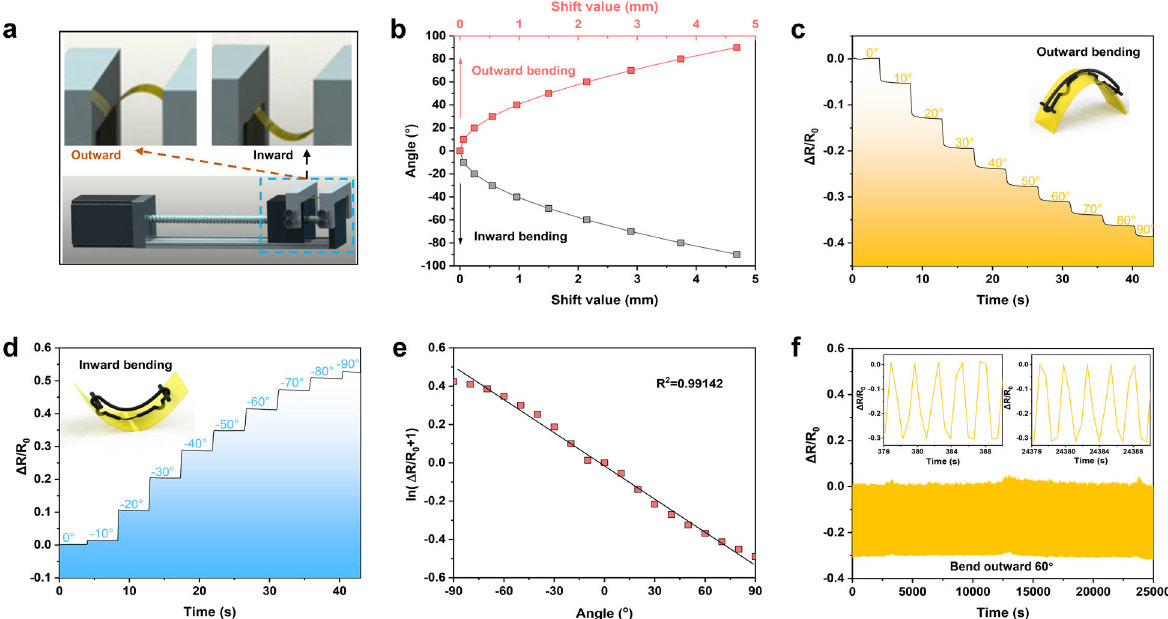
Fig. 2 Performance characterization of bending sensor. a Schematic illustration of the bending sensor fi xed to a bend-driver setup in order to detect the response in resistance of the sensor when at outward bending and inward bending. b Relationship of bending angle and shift value. c Responses in resistance of the H-junction bending sensor when at outward bending. d Responses in resistance of the H-junction (cid:4) (cid:5) þ 1 under various bending angle. f Responses in resistance of the H-junction bending sensor when at inward bending. e Value of ln Δ R R bending sensor under outward bending over 10,000